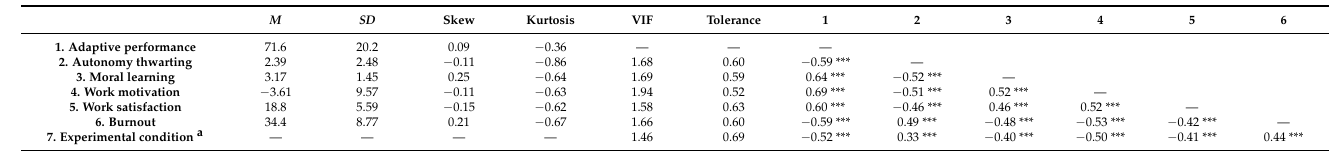
Table 4. Pearson’s Correlations and Multicollinearity Diagnostics for the Variables Included in the Tested Model.